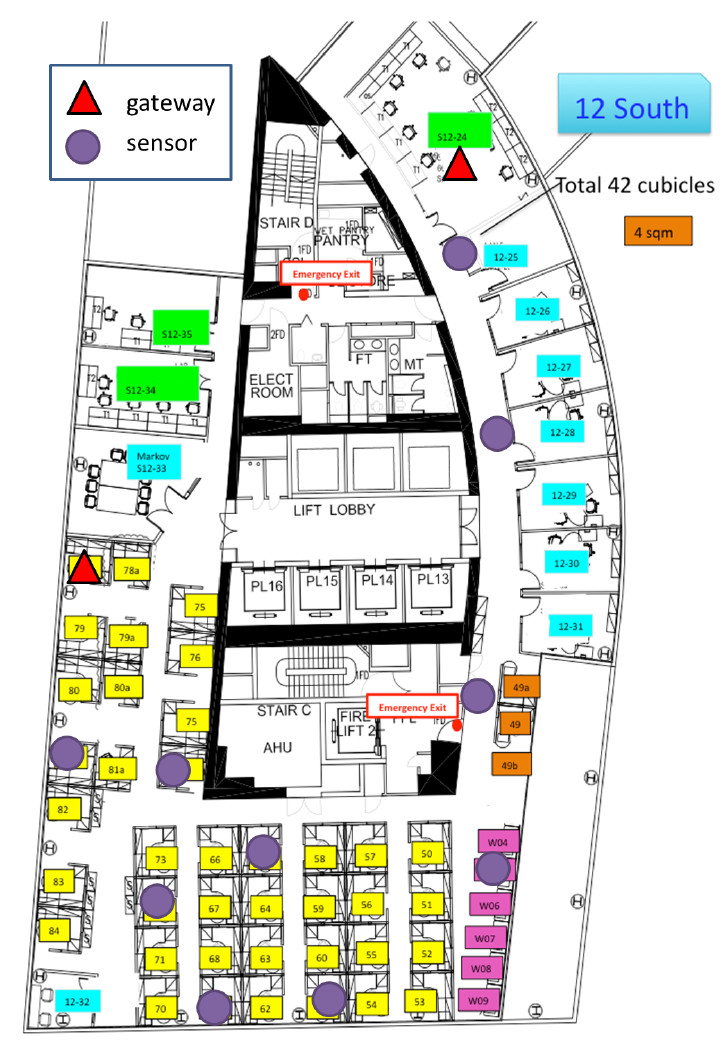
Figure 1. Experiment